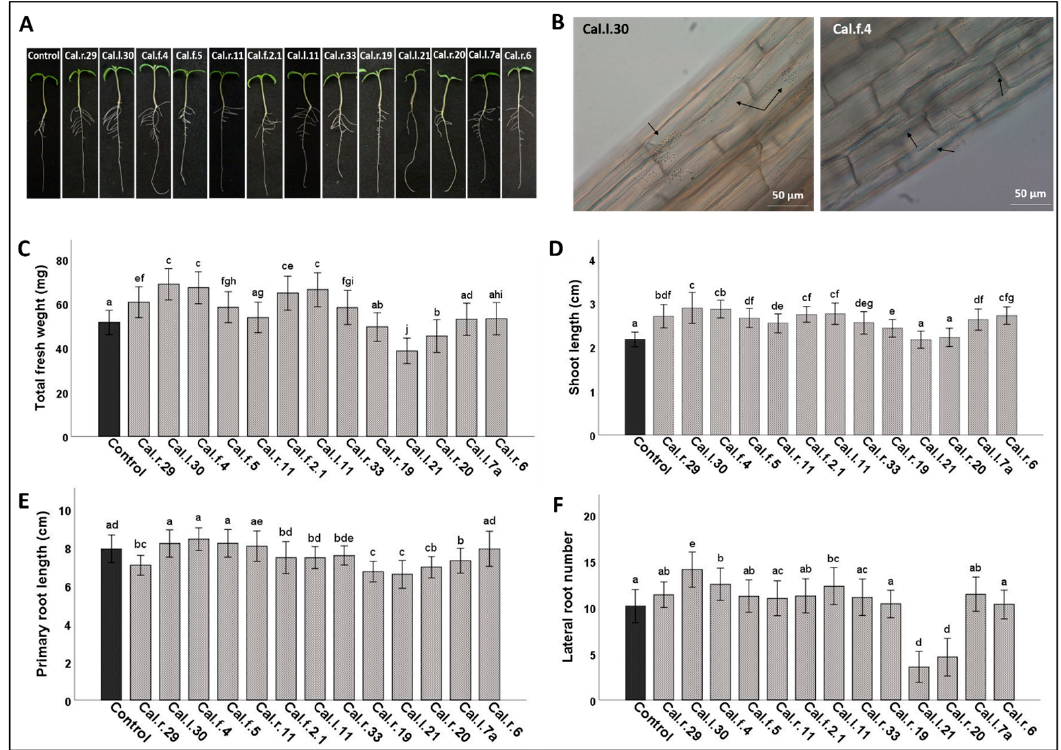
Figure 8. Tomato seed bio-priming with endophytic bacterial strains. ( A ) Tomato seedlings’ morphology, ( B ) Root colonization by endophytic strains Cal.l.30 and Cal.f.4., ( C ) Total fresh weight (mg), ( D ) Shoot length (cm), ( E ) Primary root length (cm) and ( F ) Lateral root number. Data values represent the mean of 45 seedlings ± SD per treatment. Different letters indicate statistically significant differences among treatments, based on Tukey’s test at p = 0.05.